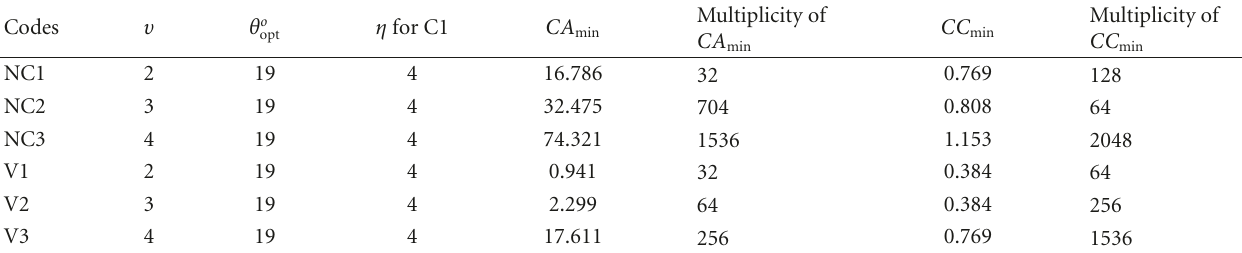
Table 2: Comparison of new (NC1, NC2, NC3) and reference (V1, V2, V3) QPSK codes.